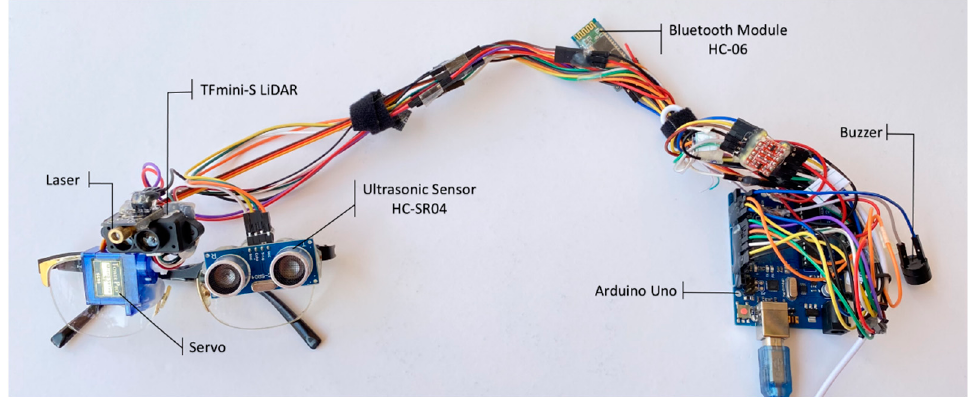
Figure 5. LidSonic device prototype (the glasses and Arduino Uno).